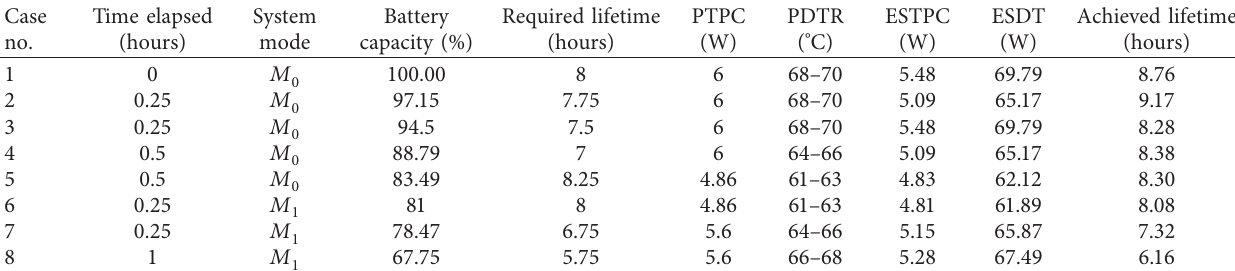
Table 4: Flow of events discussed in Section 7.